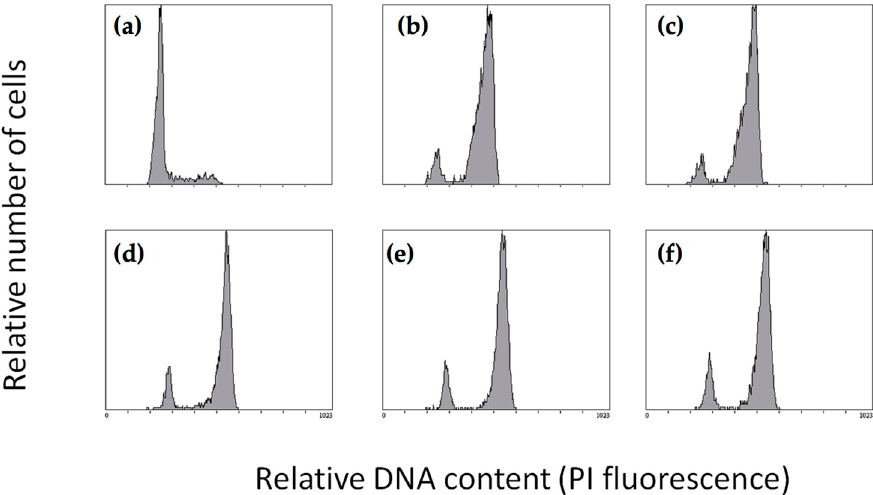
Figure 2. Cell cycle histograms. A549 lung carcinoma cells were incubated for 20 h with either ( a ) DMSO (Dimethylsulfoxyde); ( b ) 250 nM QA 1 ; ( c ) 250 nM QA 2 ; ( d ) 10 µM QA 3 ; ( e ) 100 nM Colchicine; or ( f ) 50 nM Pironetin. The histograms shown correspond to the lowest ligand concentration that induces maximal cell cycle arrest in the G2/M phase, and are generated by counting 5000 cells by flow cytometry.